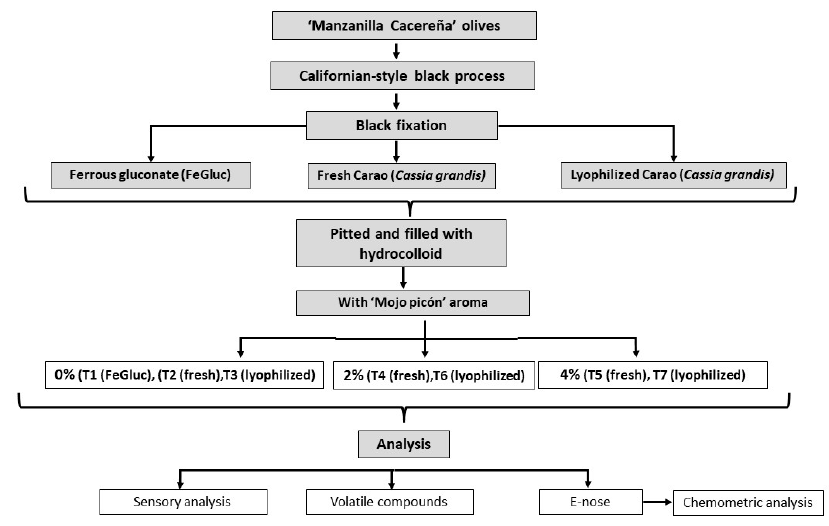
Figure 1. Diagram of the experimental design.